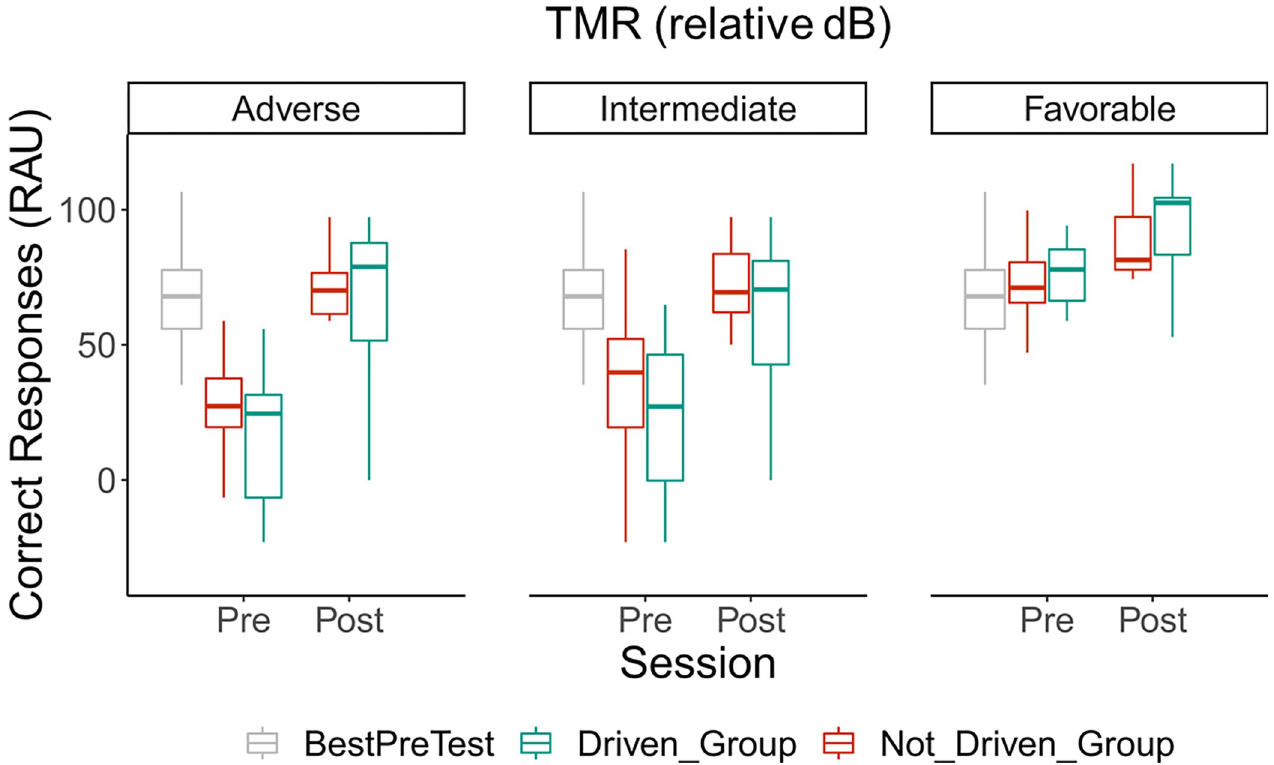
Fig 7. Speech intelligibility scores (RAUs) for each TMR (adverse, intermediate, favorable), training session (pre, post), training group (driven, not driven) and the 24 best performers of Experiment I (BestPreTest). Boxplots show medians (horizontal bars) and interquartile ranges (boxes). Whiskers reach from the lowest to the highest observed value within the 1.5 interquartile